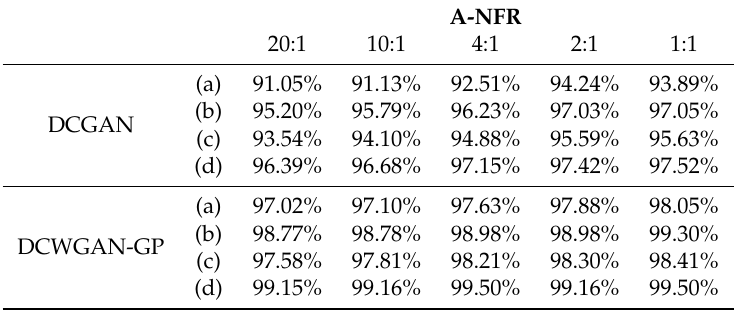
Table 4. Accuracy of original data and oversampled data using the deep convolution generative adversarial network (DCGAN) and the proposed Wasserstein generative adversarial networks with gradient penalty (WGAN-GP) on DCGAN architecture model (DCWGAN-GP) method. (a) Normal- to-fault ratio (NFR) = 200:1 with 10,000 normal data; lower bound = 90.77% at NFR=200:1, upper bound = 98.99% at NFR = 20:1. (b) NFR = 100:1 with 10,000 normal data; lower bound = 94.63% at NFR=100:1, upper bound = 98.99% at NFR = 20:1. (c) NFR = 400:1 with 20,000 normal data; lower bound = 91.30% at NFR=400:1, upper bound = 99.42% at NFR = 40:1. (d) NFR = 200:1 with 20,000 normal data; lower bound = 95.63% at NFR=200:1, upper bound = 99.42% at NFR = 40:1. A-NFR